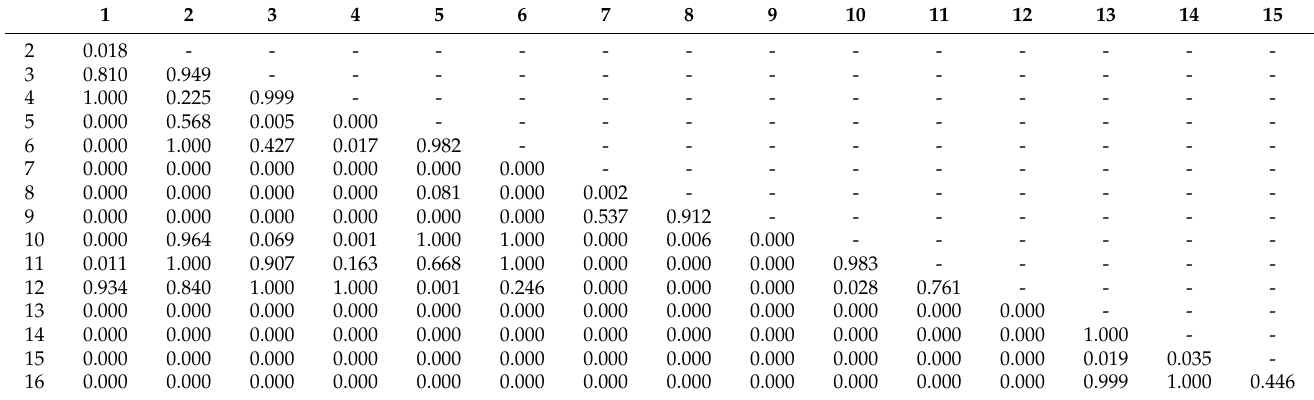
Table A5. p -values obtained from the Nemenyi test applied to the PSNR results. Row/Column names are listed in Table A2.